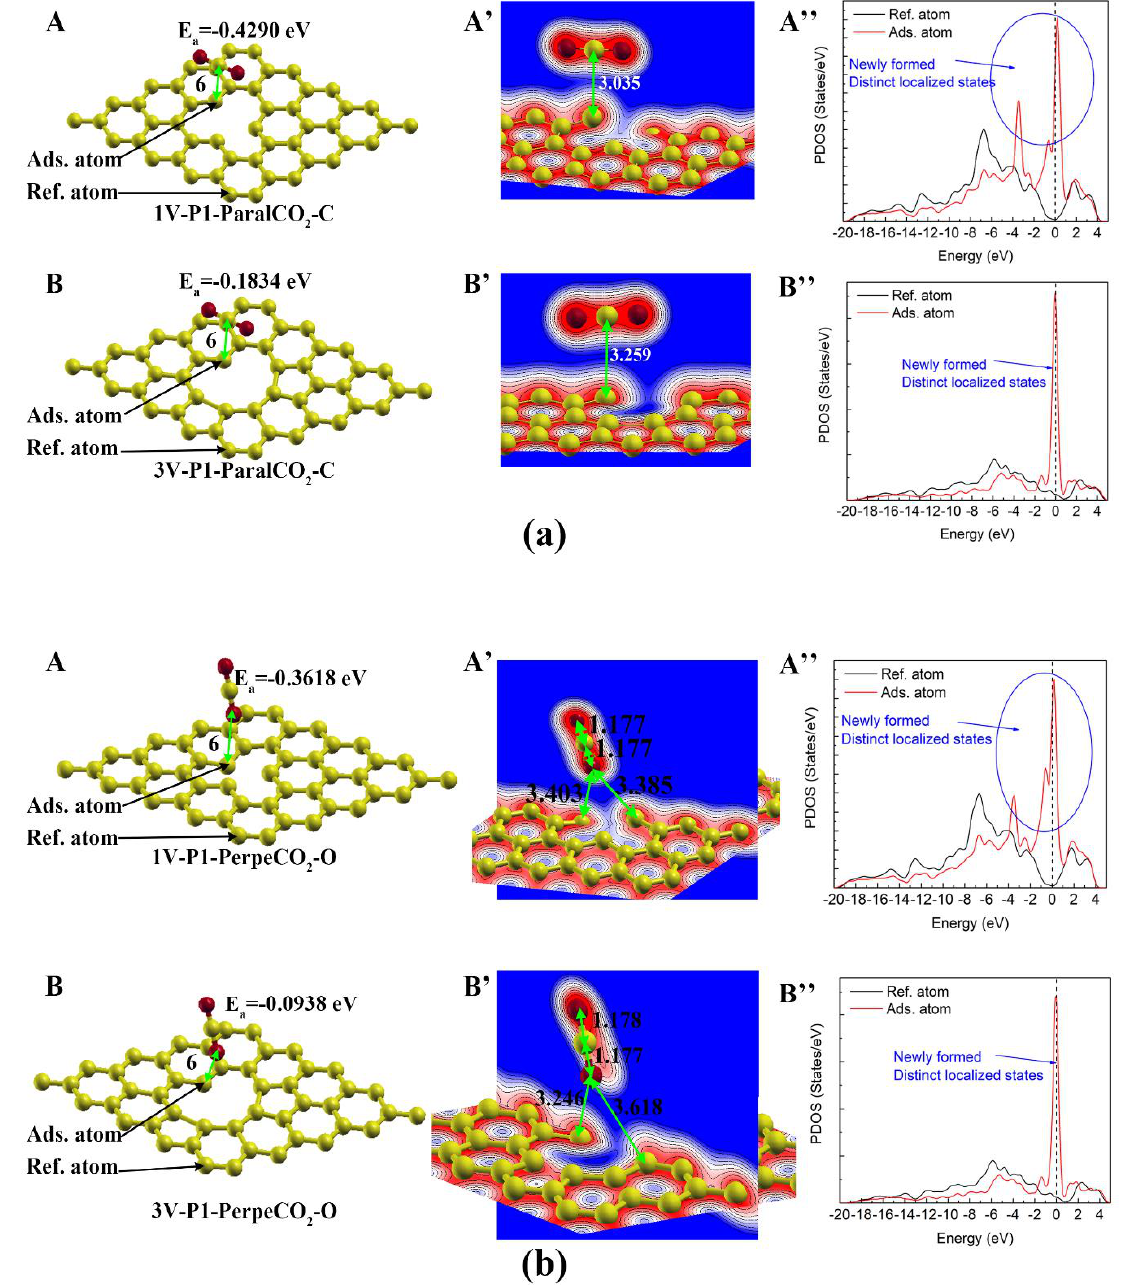
Figure 7. CO 2 physisorption on carbon atoms with dangling bonds: ( a ) and ( b ) represent adsorption with CO 2 molecules parallel to the graphene sheet and those perpendicular to the graphene sheet, respectively. ( A , A’ , A” ) and ( B , B’ , B” ) represent the atomic structure/charge distribution/PDOS of the adsorption configuration on monovacancy (1V) and trivacancy (3V) defects, respectively. The Fermi level is represented by the dashed vertical line.